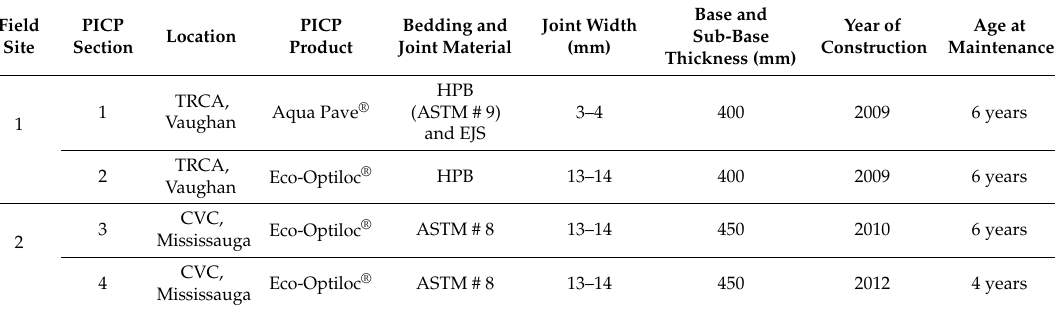
Table 1. Characteristics of Pavement